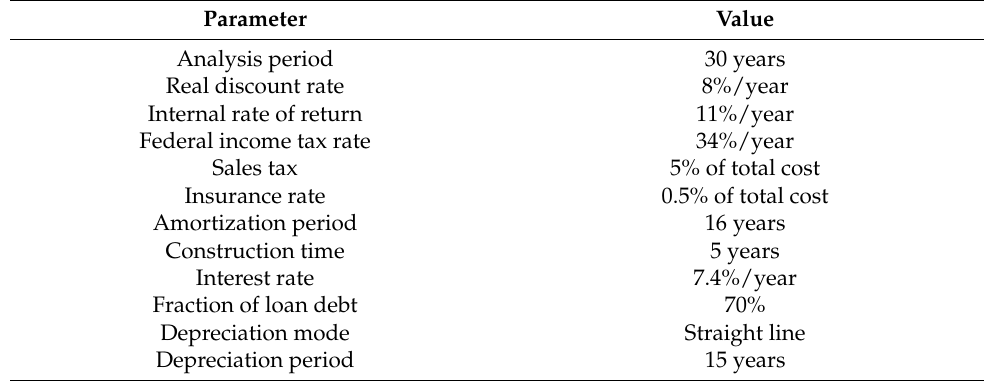
Table 3. Economic parameters used in the simulations [42,43].